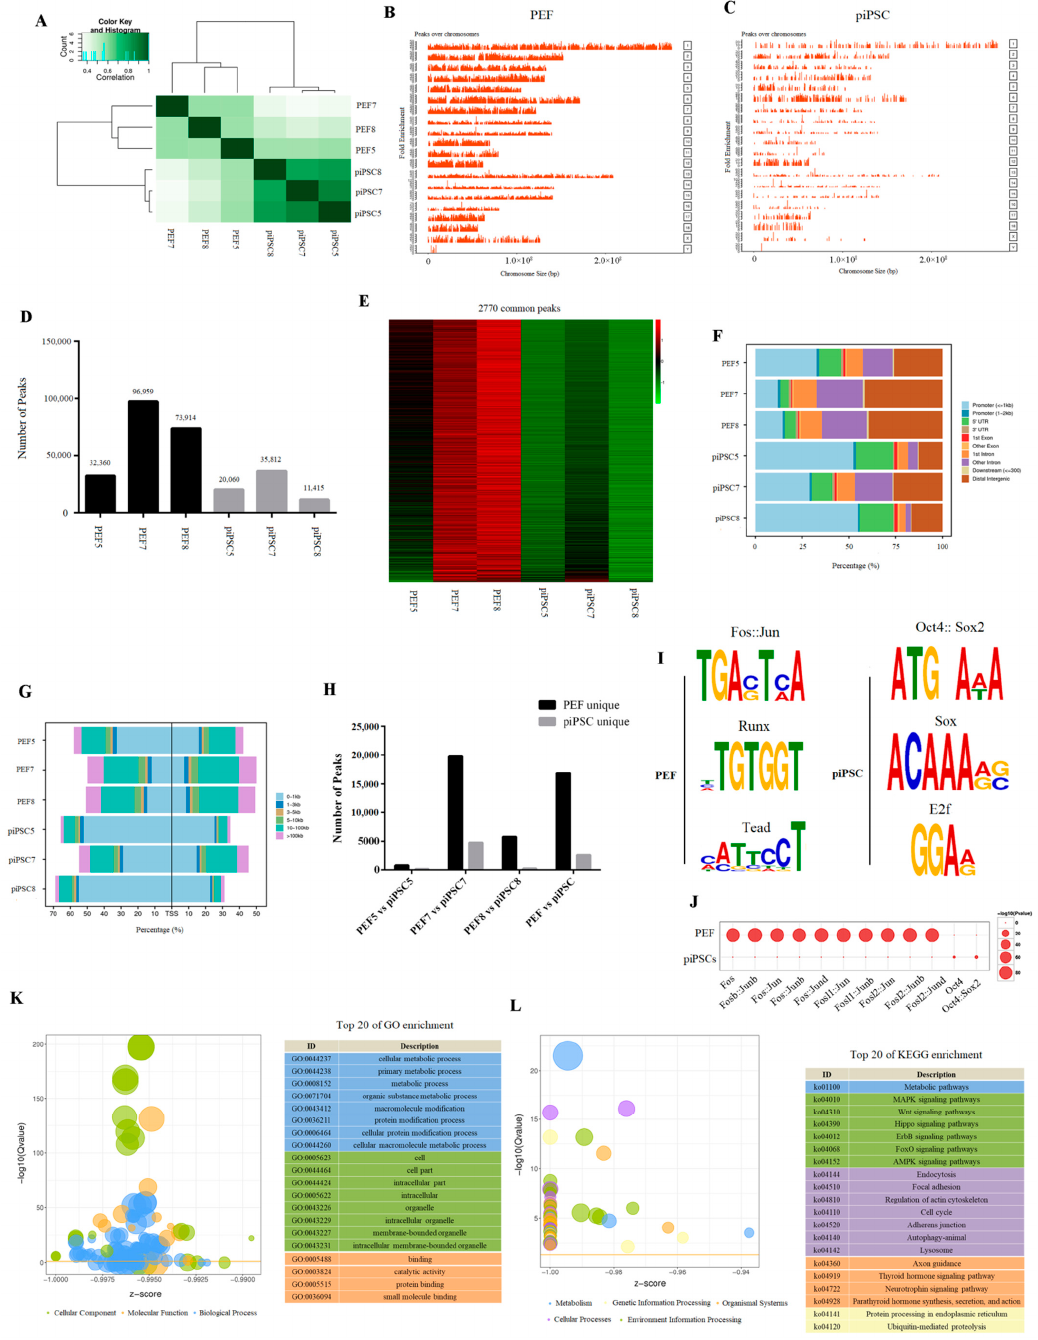
Figure 2. Differential chromatin accessibility between genetically matched PEFs and piPSCs. ( A ) Heatmap analysis of PEFs and piPSCs in ATAC ‐ seq data. ( B , C ) Peaks over chromosomes in PEFs